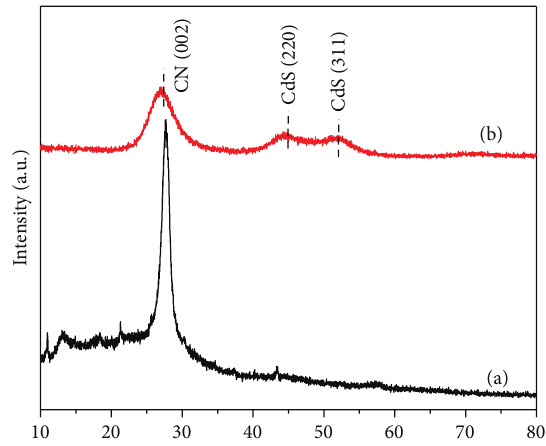
Figure 2: XRD patterns of the as-prepared samples: (a) carbon nitride; (b)